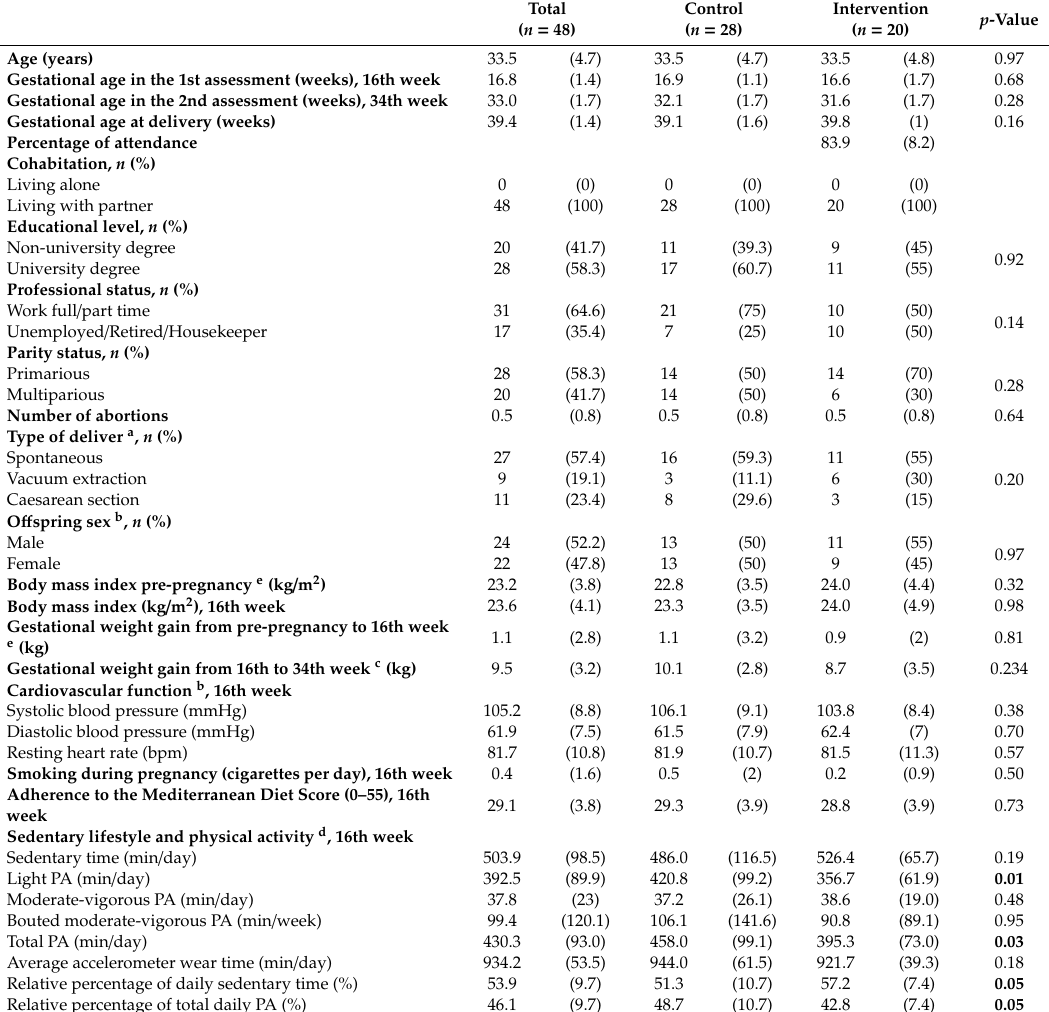
Table 1. Sociodemographic and clinical characteristics of pregnant women ( n =